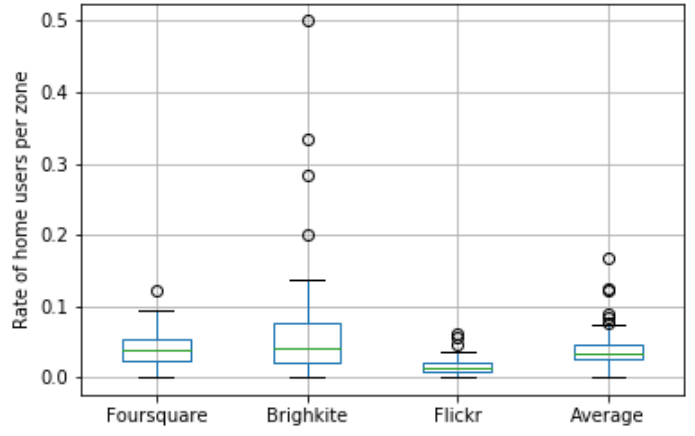
Figure 9. Rate of home users per OSN and zone along with the averaged rates comprising all the